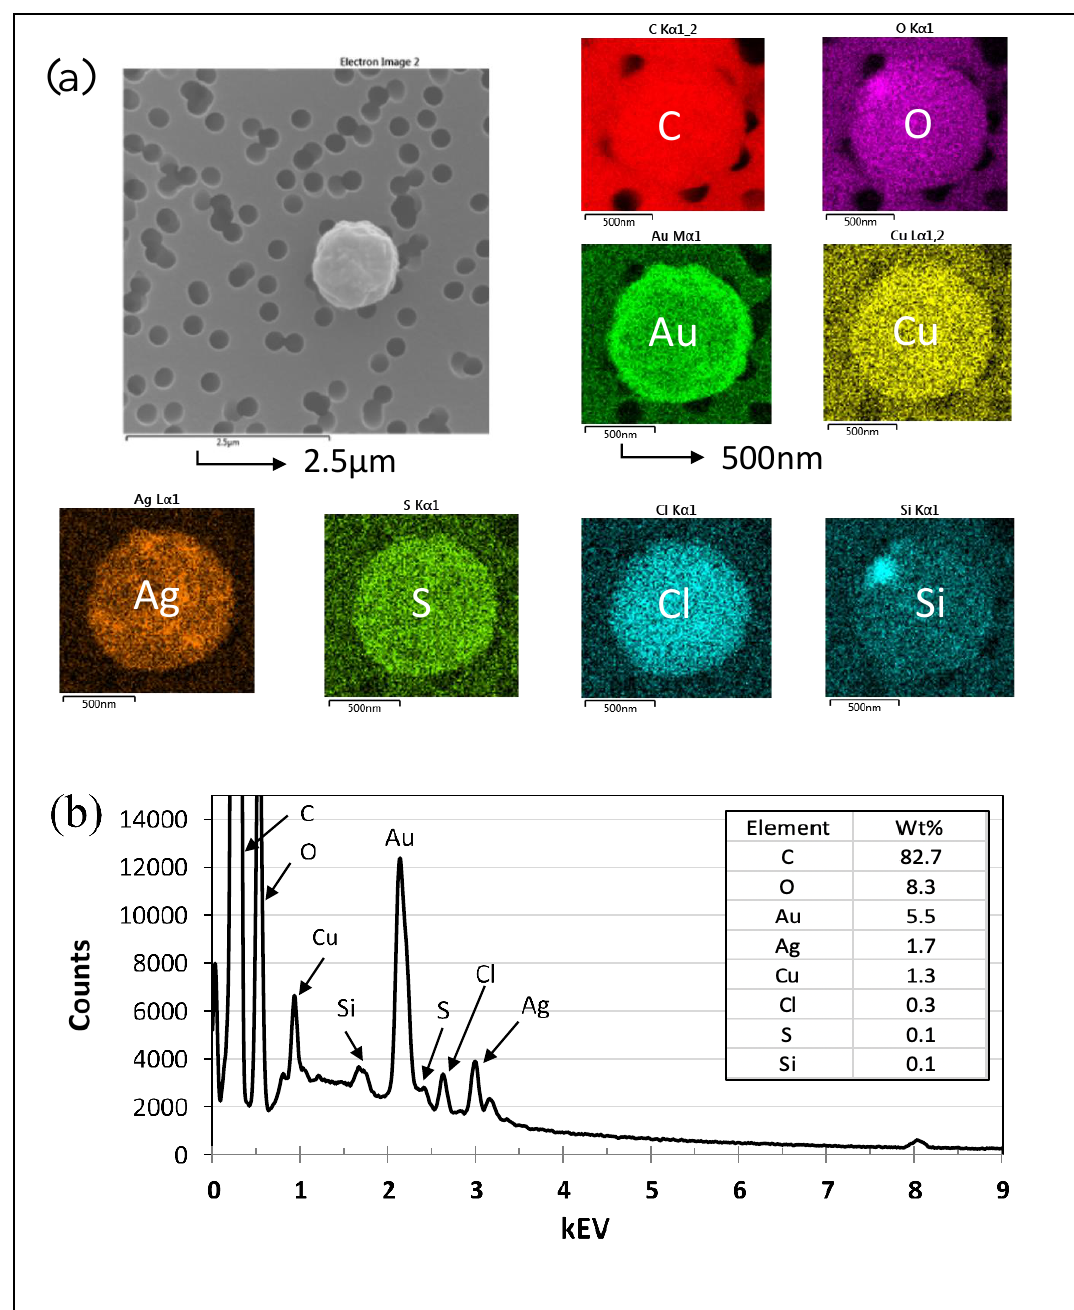
Figure 5. Microscopy analysis of particles aerosolized from STS. ( a ) SEM-EDS image of particles used for analysis. The scale bar of the SEM image is 2.5 µ m. This particle was found to contain the elements carbon (C), oxygen (O), gold (Au), copper (Cu), silver (Ag), sulfur (S), chlorine (Cl), and silicon (Si) from left to right, with scale bars of 500 nm. ( b ) EDS analysis of the particle in image (a). Note: Au was used as the coating and therefore was excluded from further analysis or discussion.